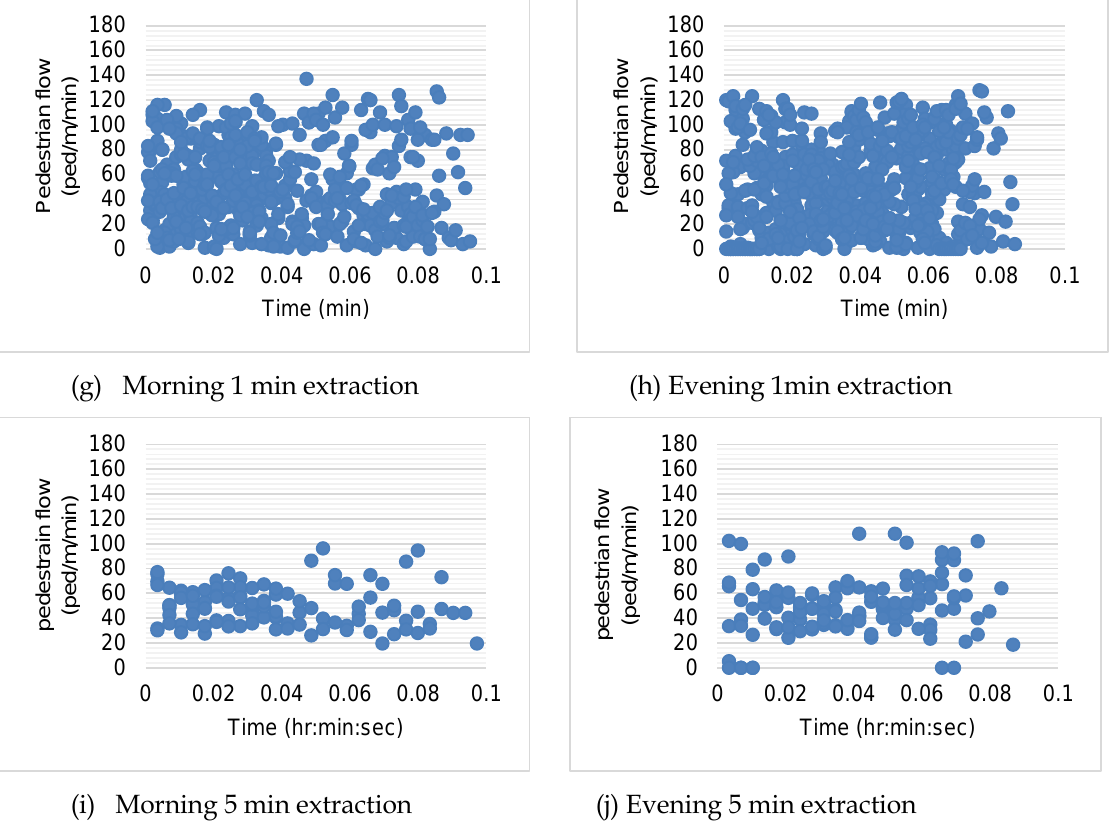
Figure 2. Variation in Pedestrian Flow for Different Data Extraction Count